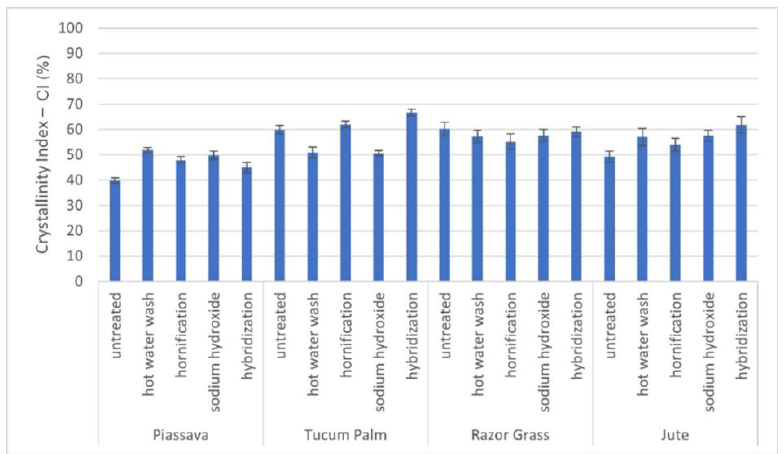
Figure 3. Results of crystallinity index — CI % of untreated and treated fibers. Four fibers: piassava, tucum palm, razor grass, and jute.